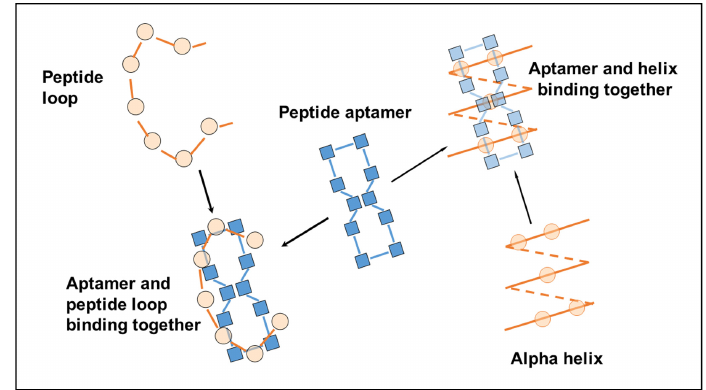
Figure 3. Peptide aptamers are a close fit with common structures in proteins.